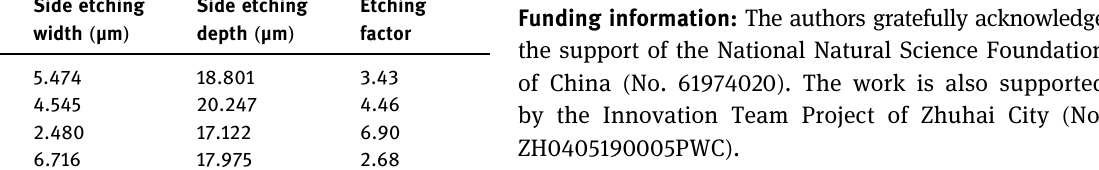
Table 6: Etch factors of the copper circuits shown in Figure 11e – h